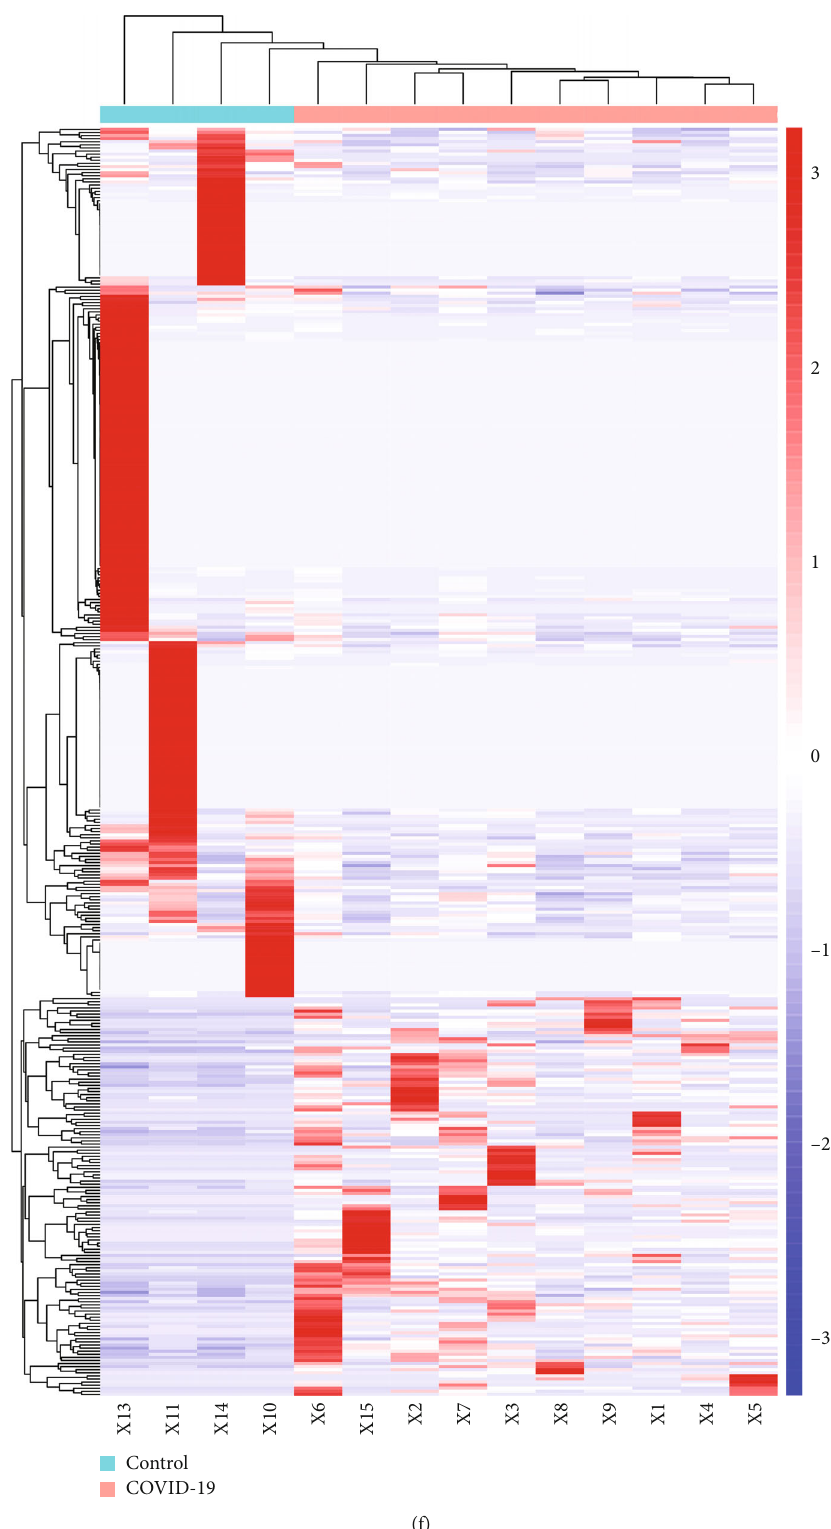
Figure 2: Volcano plots and heatmaps of di ff erentially expressed genes (DEGs). Volcano plots showing signi fi cantly di ff erent expressions of mRNAs (a), miRNAs (b), and lncRNAs (c) between the COVID-19 and control groups. Red points: upregulated DEGs; blue points: downregulated DEGs; gray and green points: the genes with no obvious di ff erence in expression levels. Heatmaps of DE mRNAs (d), DE miRNAs (e), and DE lncRNAs (f). Red represents upregulation, and blue represents